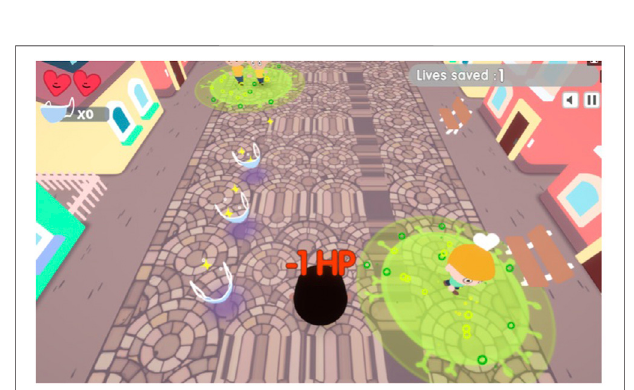
FIGURE 10 | Interactive Covid-19 game (Wiseman and Martin,